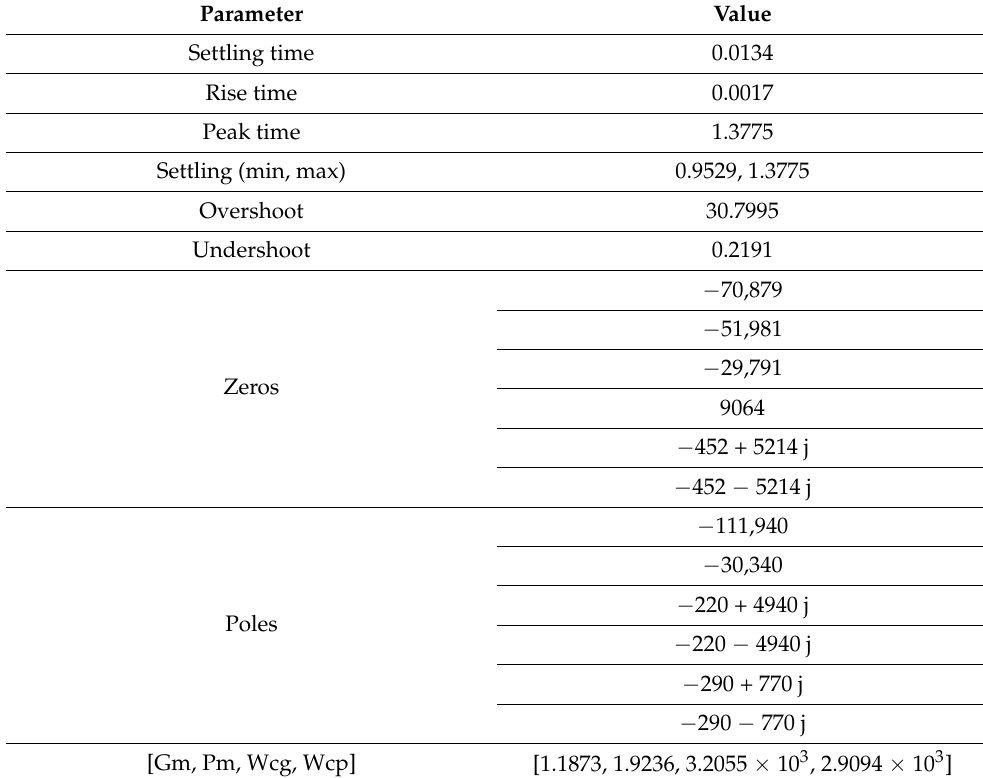
Figure 8. Root locus for the SCZEBC converter.